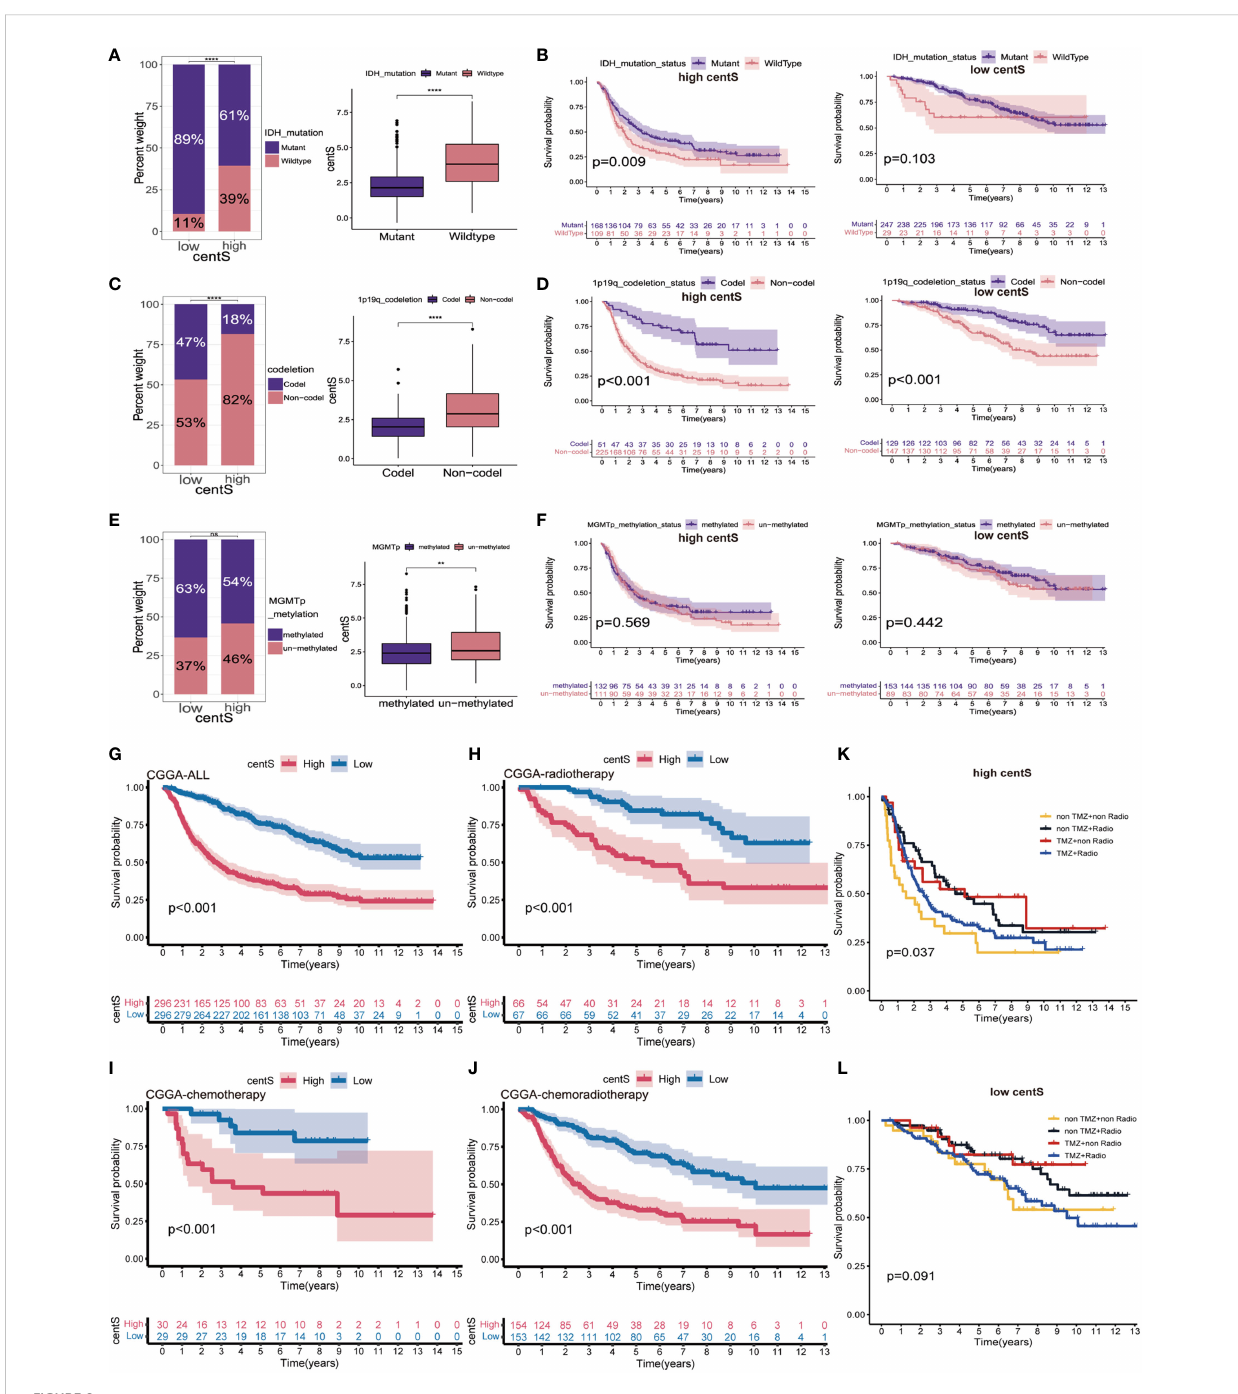
FIGURE 9 The potential association of centS with genetic status and therapy methods in LGG. Statistical histogram and difference analysis to explore the association of centS with IDH mutation status (A) , 1p19q co-deleted status (C) and MGMT promoter status (E) . OS analysis to show the effects of IDH mutation status (B) , 1p19q co-deleted status (D) MGMT promoter status (F) on prognosis of high- and low- centS groups. OS analysis of high- and low- centS groups in the CGGA cohort (G) , CGGA chemotherapy cohort (H) , CGGA radiotherapy cohort (I) , and CGGA chemo radiotherapy cohort (J) . The response of patients with LGG in the high- centS group (K) and low- centS group (L) to different combination of treatments. centS, centrosome score. **p < 0.01; ****p < 0.0001; "ns", not statistically signi fi